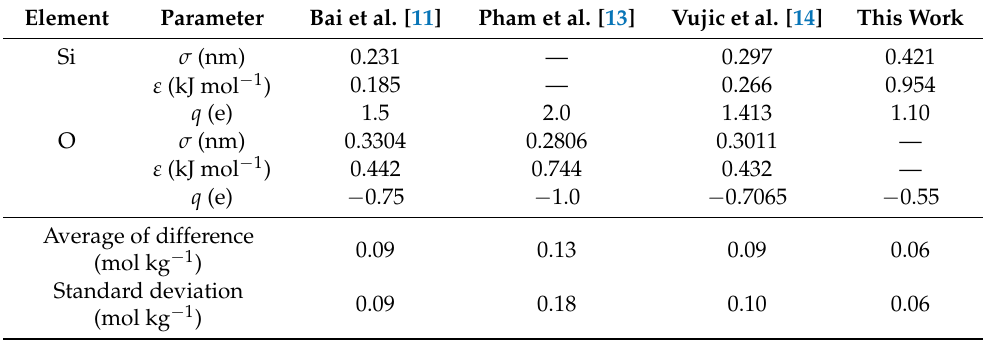
Table 4. Non-bonding interaction parameters of all-silica zeolites, averages of differences between the amounts of adsorbed obtained by the experiment and simulation, and their standard deviations.